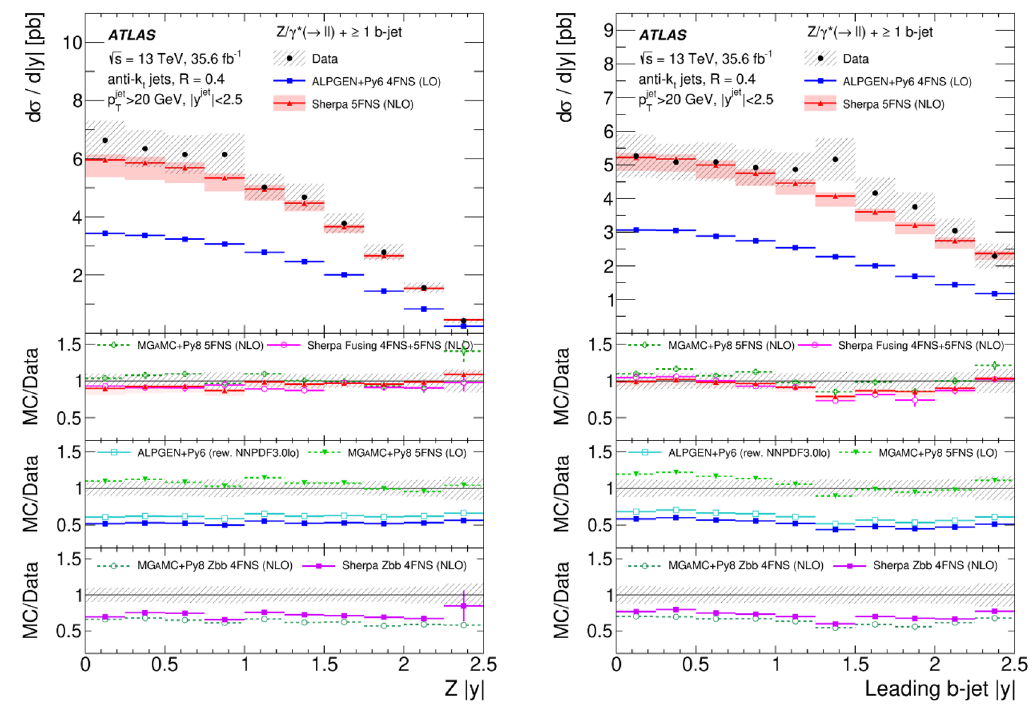
Figure 9 . Measured cross-section as a function of Z -boson j y j (left) and leading b -jet j y j (right) in events with at least one b -jet. The data are compared with the predictions from Sherpa 5FNS (NLO) , Alpgen + Py6 4 FNS (LO) , Sherpa Fusing 4FNS+5FNS (NLO) , Sherpa Zbb 4FNS (NLO) , MGaMC + Py8 5FNS (LO) , MGaMC + Py8 Zbb 4FNS (NLO) and MGaMC + Py8 5FNS (NLO) . The error bars correspond to the statistical uncertainty, and the hatched bands to the data statistical and systematic uncertainties added in quadrature. The red band corresponds to the statistical and theoretical uncertainties of Sherpa 5FNS (NLO) added in quadrature. Only statistical uncertainties are shown for the other